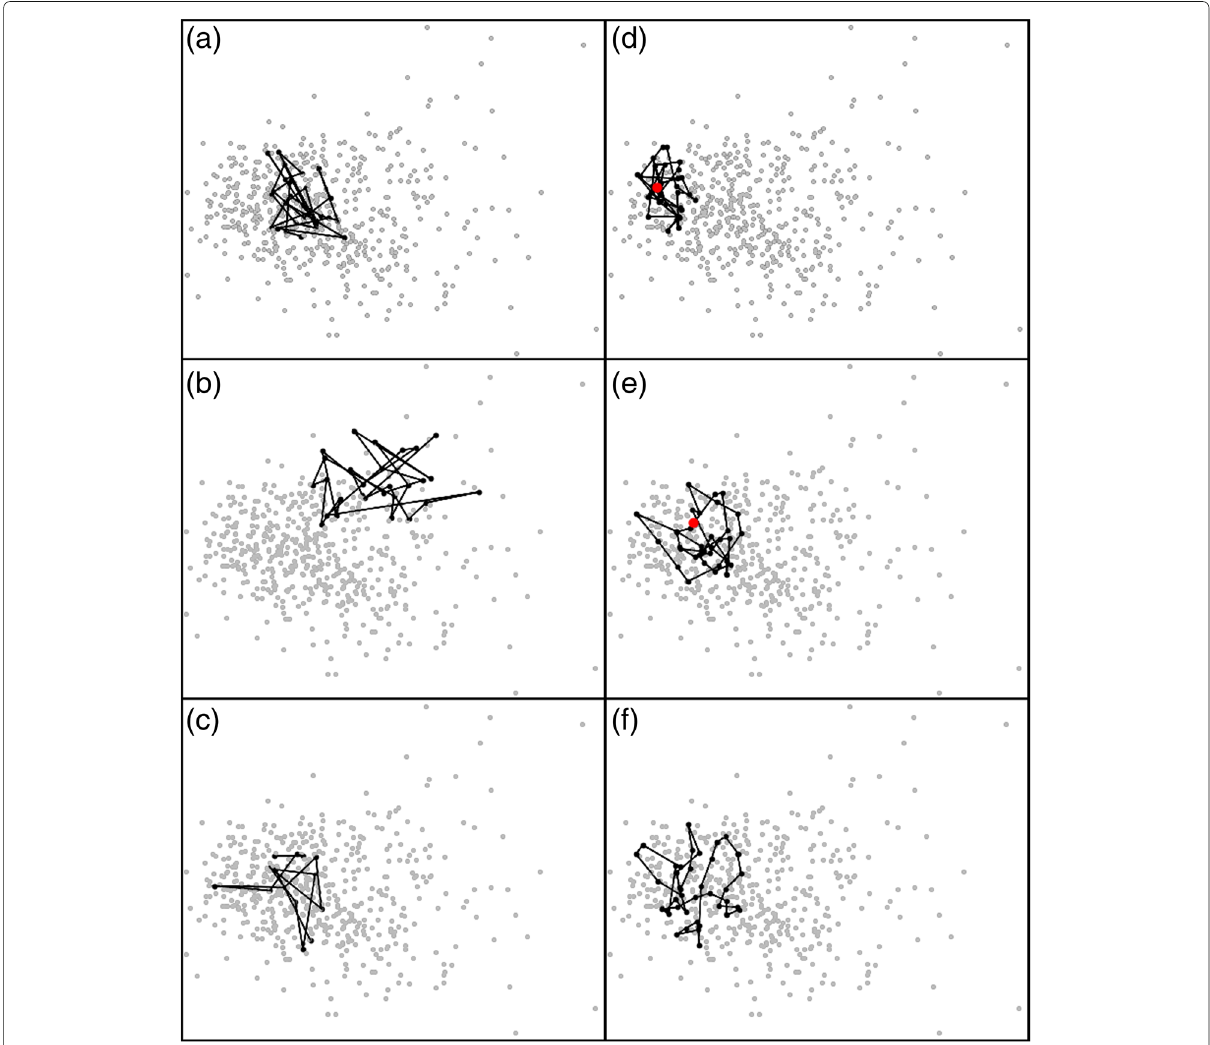
Fig. 10 Illustration of the style descriptor progression throughout six DJ mixes. The gray dots represent the style descriptors of 513 Drum and Bass songs, selected from different sub-genres of Drum and Bass. The black dots mark the songs in the mix. Successive songs are connected by a line. a , b , c Professional DJ mixes, resp. [54–56]. d , e , f Generated DJ mixes. The style centroid is marked by a red dot. d Default settings for (α , β) = ( 0.4, − 0.1 ) . e Large β : (α , β) = ( 0.4, − 0.9 ) . f No style centroid, large β : (α , β) = ( 0, − 0.5